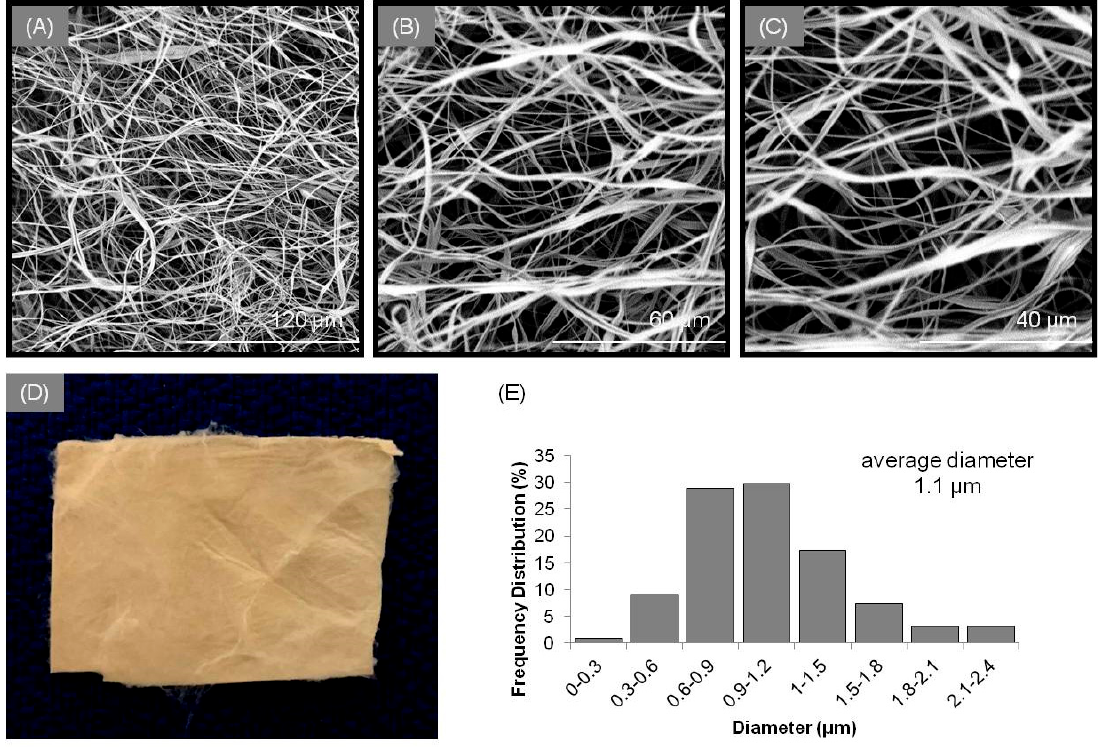
Figure 1. SEM images of the PHBE micro/nanofibrous patch at ( A ) 1000 × , ( B ) 2000 × , and ( C ) 3000 × magnification. ( D ) Image of a PHBE micro/nanofibrous patch. ( E ) Average diameter distribution histogram of fibers in PHBE dressings.